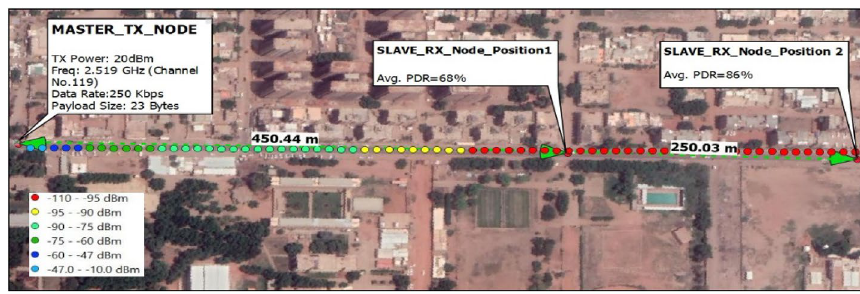
Fig. 5 Second and third test scenarios (Sudan University Southern Campus, Street